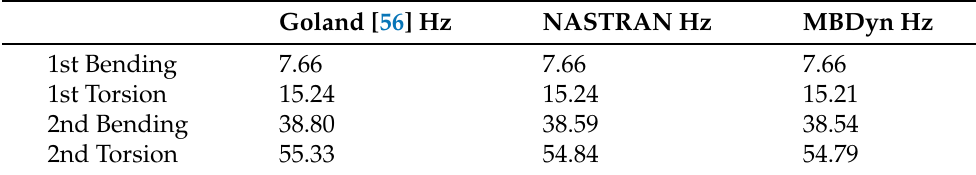
Table 2. Comparison of the first four natural frequencies computed for the Goland’s wing